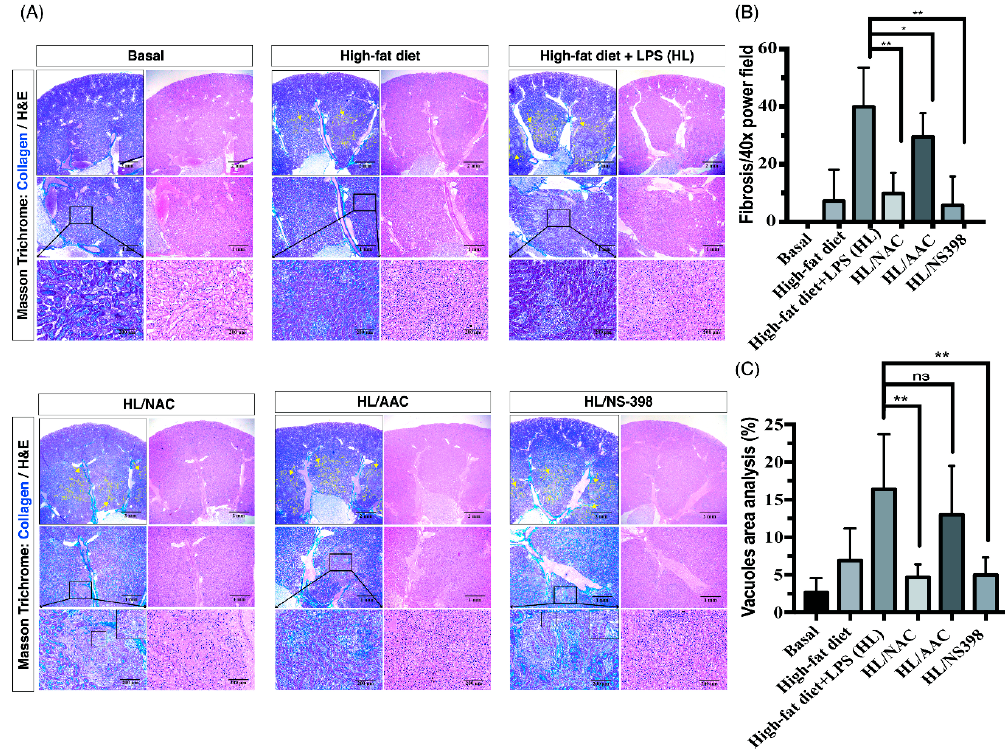
Figure 3. Inhibitors of reactive oxygen species (ROS), cPLA2, and COX-2 attenuate the tubulointerstitial fibrosis in HF mice with ME. ( A ) The HL group exerts the most significant collagen deposition and tubulointerstitial fibrosis in the juxtamedullary to medullar regions. In corresponding fibrotic regions, the HL/N-acetylcysteine (NAC) group exhibited residual renal tubular structures, suggesting that the above fibrotic process was attenuated (zoom-in region). Under high-power magnification, evident epithelioid tubular-like cells were also visible in corresponding fibrotic regions in the HL/NS-398 group (zoom-in region), indicating tissue repair after inflammation. In contrast with the profound tubularinterstitial fibrosis in HL group, inhibitor-treated groups of NAC, AACOCF3 (AAC) and NS-398 attenuated such injury (yellow dotted line regions). The fibrosis area was marked by yellow dotted lines. Yellow arrows indicated the borderline of the fibrosis area. Scale bars are 2 mm, 1mm and 200 μ m in the panels. ( B ) To compare the therapeutic effects of inhibitors, the HL/NAC and HL/NS-398 group presented the lowest degree of OKF after quantification analysis for the fibrotic area verses total tissue area (%). ( C ) After quantification analysis for the area of vacuoles, the HL/NAC group exerted the lowest degree of lipid vacuole deposition in the tubular epithelium. Quantification analysis was performed by image J. Data are expressed as mean ± SD ( n = 8); * p < 0.05; and ** p < 0.01 to compare the differences between the two indicated groups. ns, not significant.